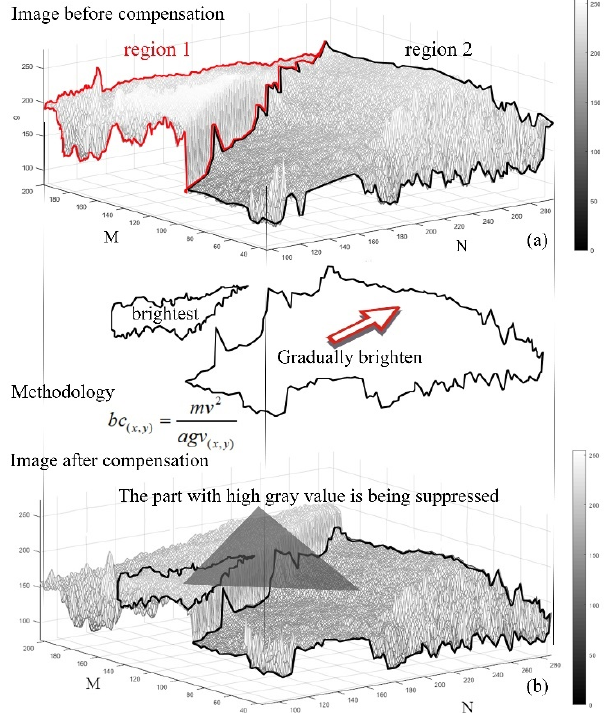
Figure 2. The principle of brightness compensation. ( a ) Image before compensation. ( b ) Image after compensation.